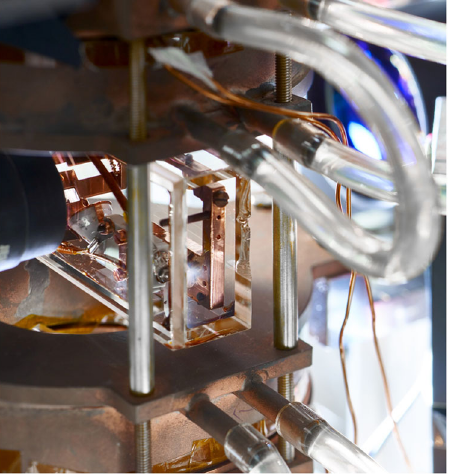
Fig. 6 Picture of a single-atom trap employed in ref. 48 . Shown is the ultra-high vacuum glass cell in which a single rubidium atom is stored (authorized by the copyright owner Jan Gruene, from LMU).